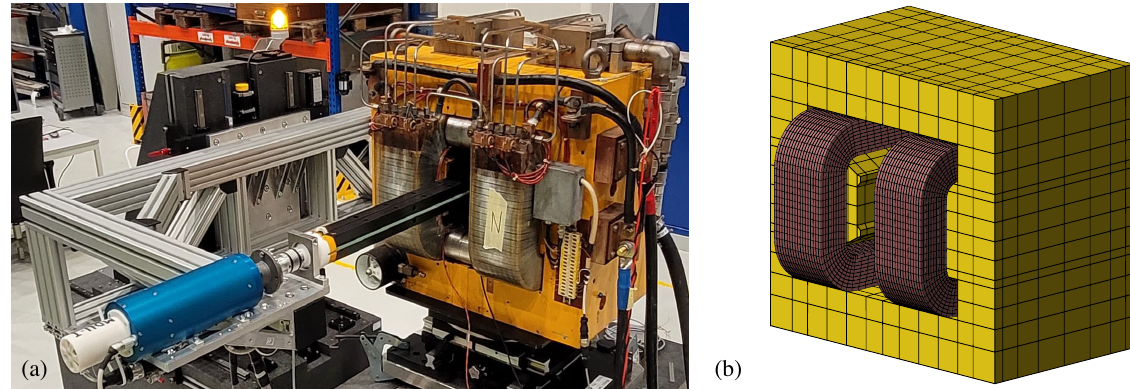
FIG. 3. The MDX magnet on the measurement system (a) and the mesh of the model